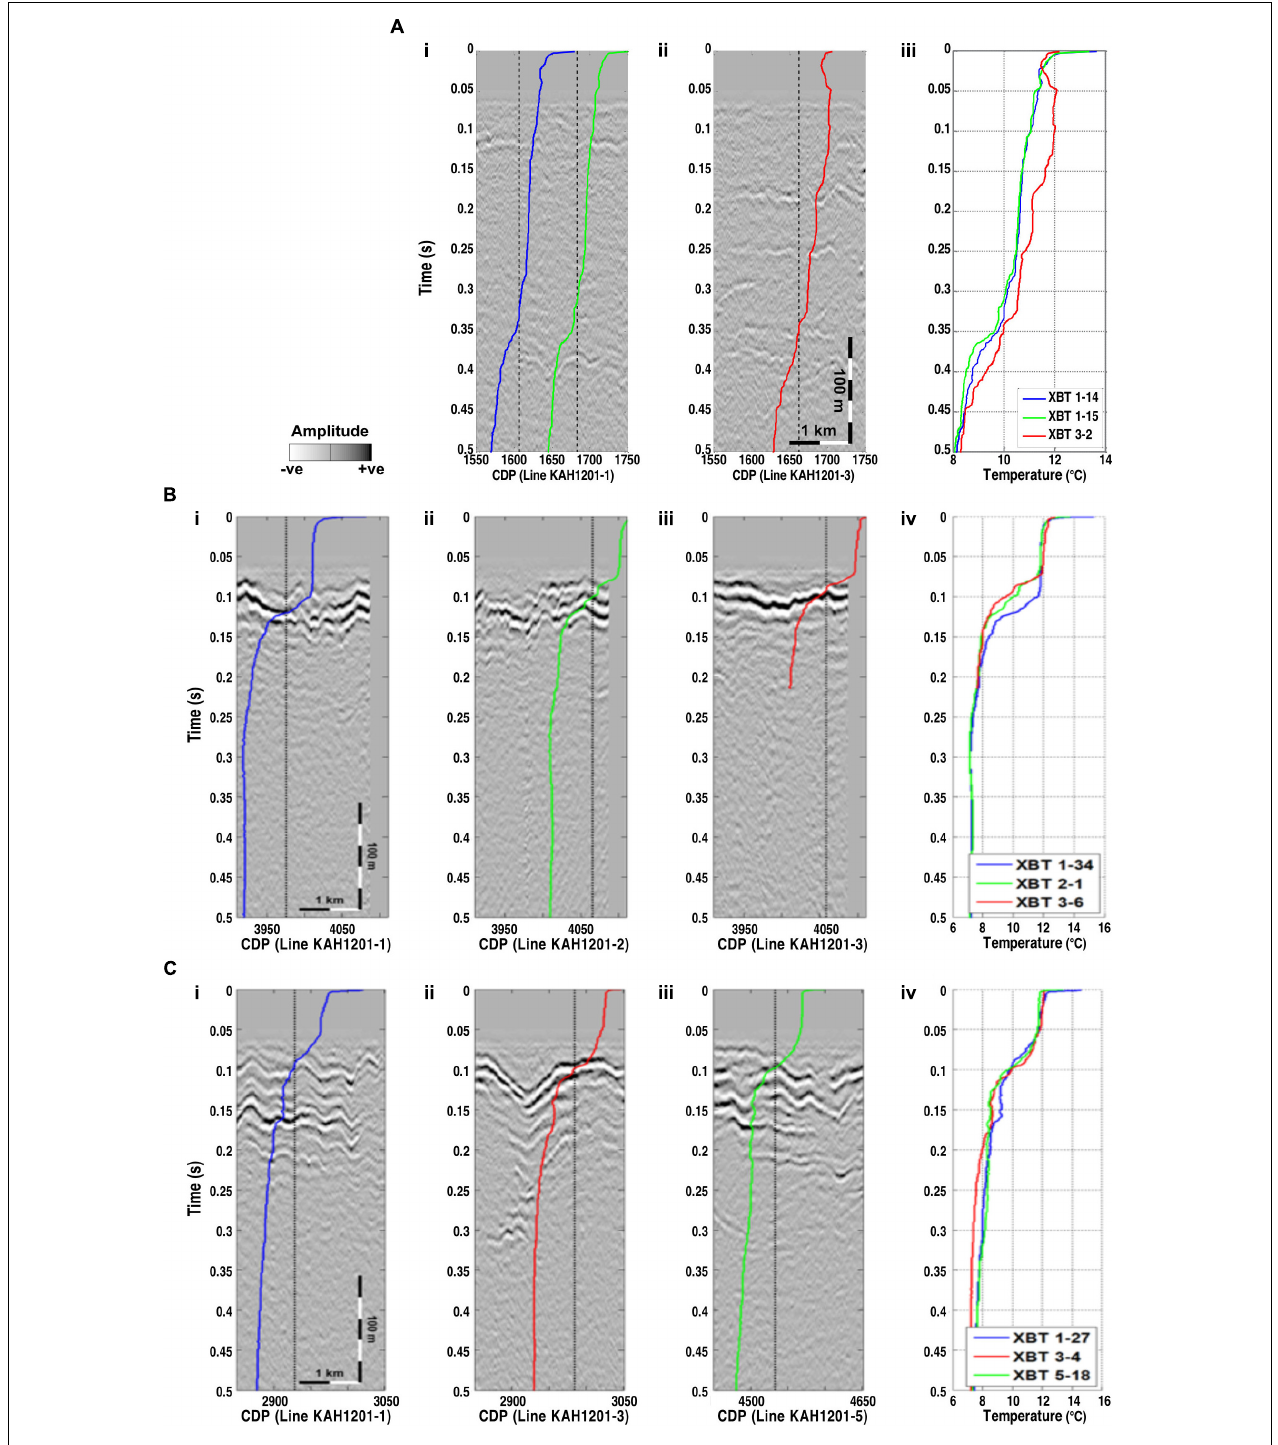
FIGURE 11 | Time-lapse XBT comparisons. Temperature traces are overlain on the seismic data, with the XBT locations shown by vertical dotted lines. (A) Portions of lines KAH1201-1 (i) and KAH1201-3 (ii) acquired in the same location within the STF zone. The three XBTs are plotted together in (iii). The time delay between XBTs 1-14 and 1-15 was 6 min, and between 1-15 and 3-2 was 19 h. (B) Portions of lines KAH1201-1 (i), KAH1201-2 (ii), and KAH1201-3 (iii) acquired in the same location at the seaward end of the Munida Transect. The three XBTs are plotted together in (iv). The time delay between XBTs 1-34 and 2-1 was 25 min, and between 2-1 and 3-6 was 18.5 h. (C) Portions of lines KAH1201-1 (i), KAH1201-3 (ii), and KAH1201-5 (iii) acquired at the intersection point of transects MUN and CB. The three XBTs are plotted together in (iv). The time delay between XBTs 1-27 and 3-4 was 19 h, and between XBTs 3-4 and 5-18 was 8